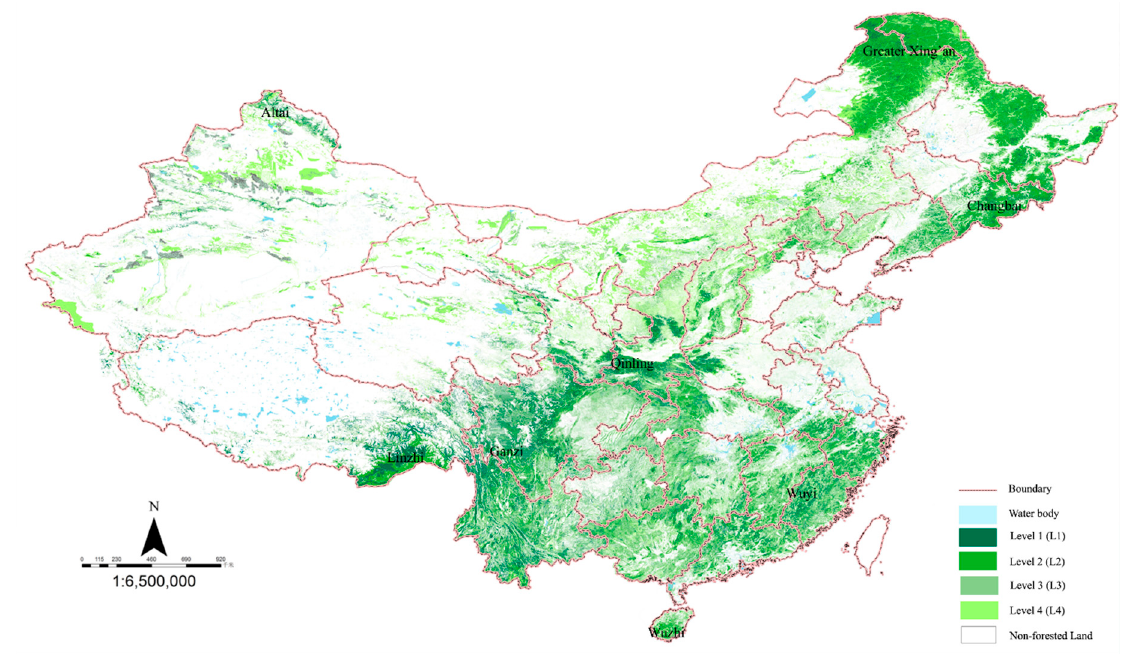
Figure 8. Forest landscape quality map of Mainland China.